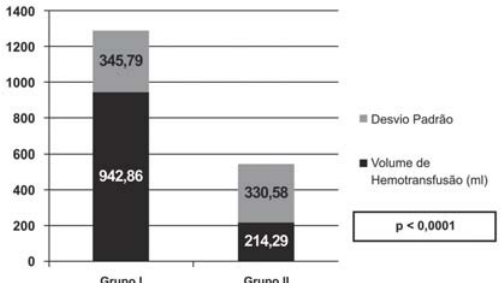
Fig. 2 - Volume de hemotransfusão - Grupo I - controle; Grupo II - ácido épsilon